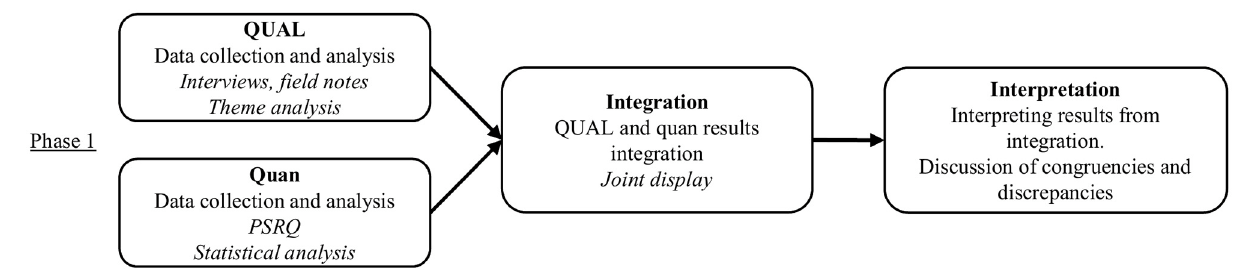
FIGURE 1 | Convergent mixed methods design process.